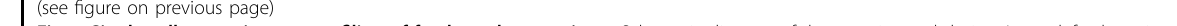
Fig. 1 Single-cell transcriptome pro fi ling of fetal monkey ovaries. a Schematic diagram of the experimental design. In total, fetal ovaries were collected from E84 and E116 monkey fetus and further enzymatically digested into single-cell suspension, which were then captured using 10× Genomics technology. The libraries of single-cell transcriptome were generated using the single-cell 3 ′ reagent V3 kits according to the manufacturer ’ s protocol. b UMAP and clustering analysis of single-cell transcriptome data from fetal monkey ovaries. The 15 clusters were assigned and colored as indicated on the fi gure key. c UMAP plot of single-cell transcriptome data with cells colored based on their embryonic stages. d Expression patterns of selected markers for the identi fi cation of cell clusters. Blue indicates high expression and gray indicates low or no expression, as shown on the fi gure key. e Heatmap showing top 10 differentially expressed genes across 15 cell clusters, and 12,471 single cells were